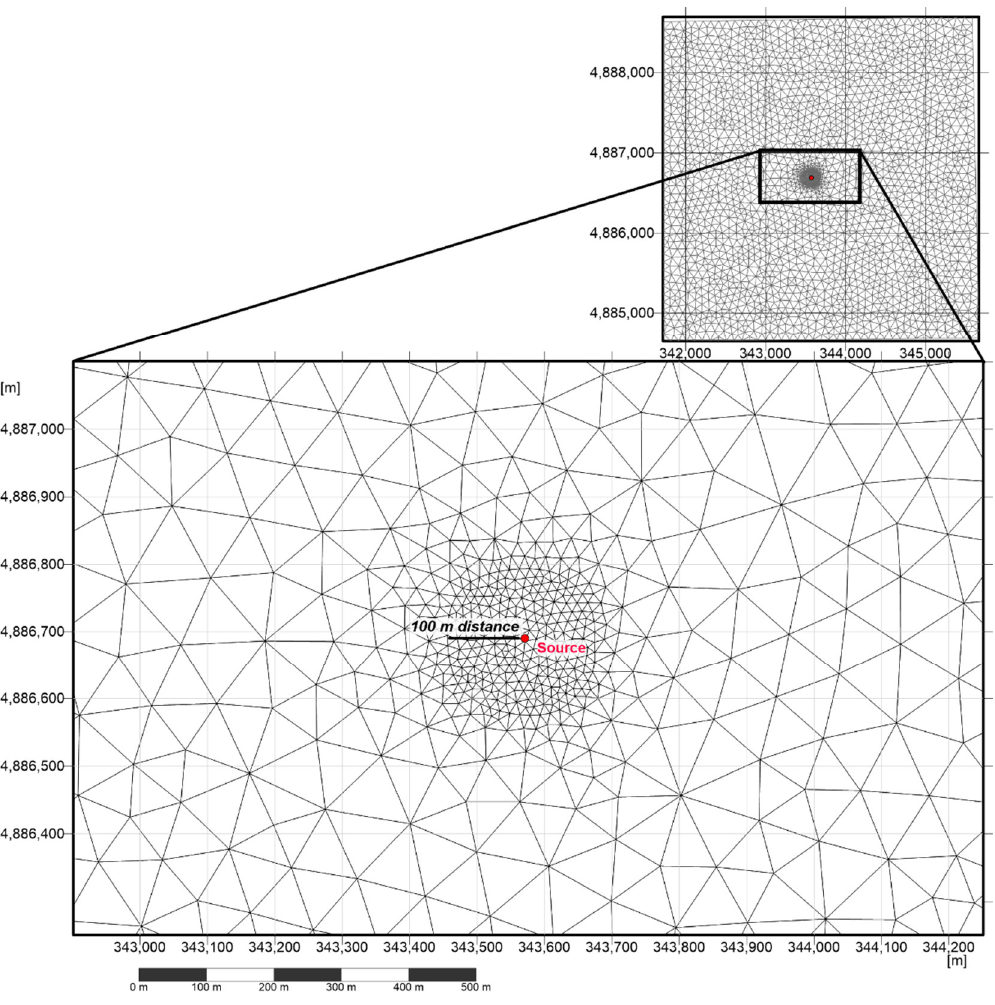
Figure 2. Model grid around platform discharge source (triangular mesh with maximum side of 100 m and minimum of 15 m).